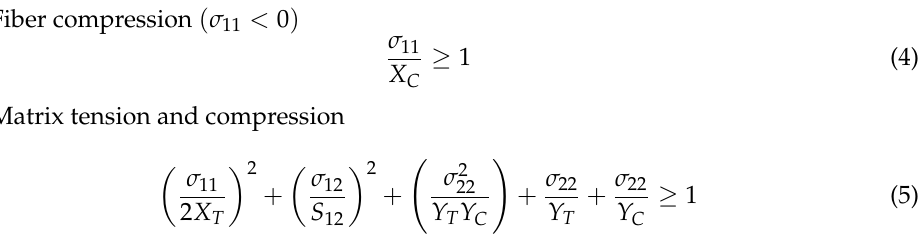
Figure 6. A bilinear mixed-mode traction – separation law.